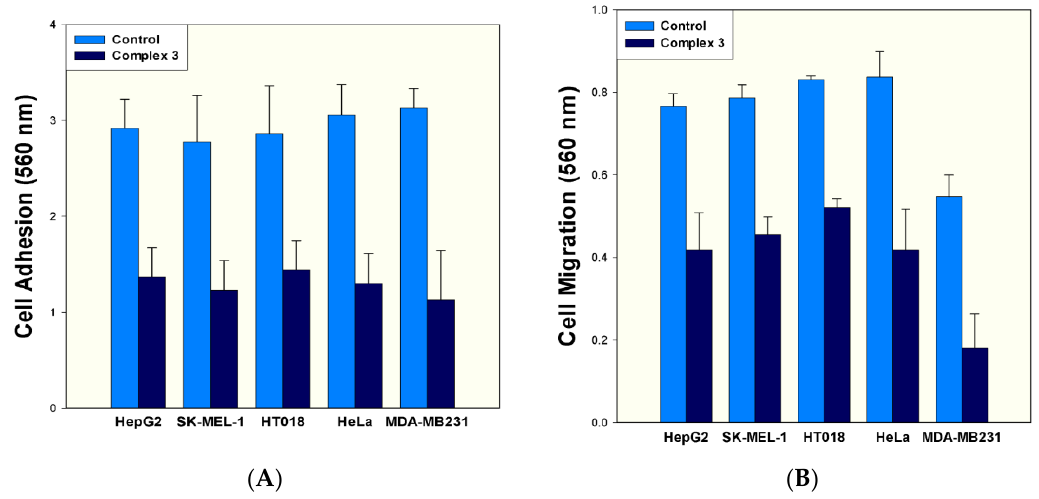
Figure 7. ( A ) Effect of complex 3 on cell adhesion against five cancer cell lines. Assays for adhesion and migration were performed with a cytoselect 24-well plate, and the absorbance of extracted samples was read at 560 nm. ( B ) Effect of complex 3 on cell migration against five cancer cell lines. Assays for adhesion and migration were performed with a cytoselect 24-well plate, and the absorbance of extracted samples was read at 560 nm.